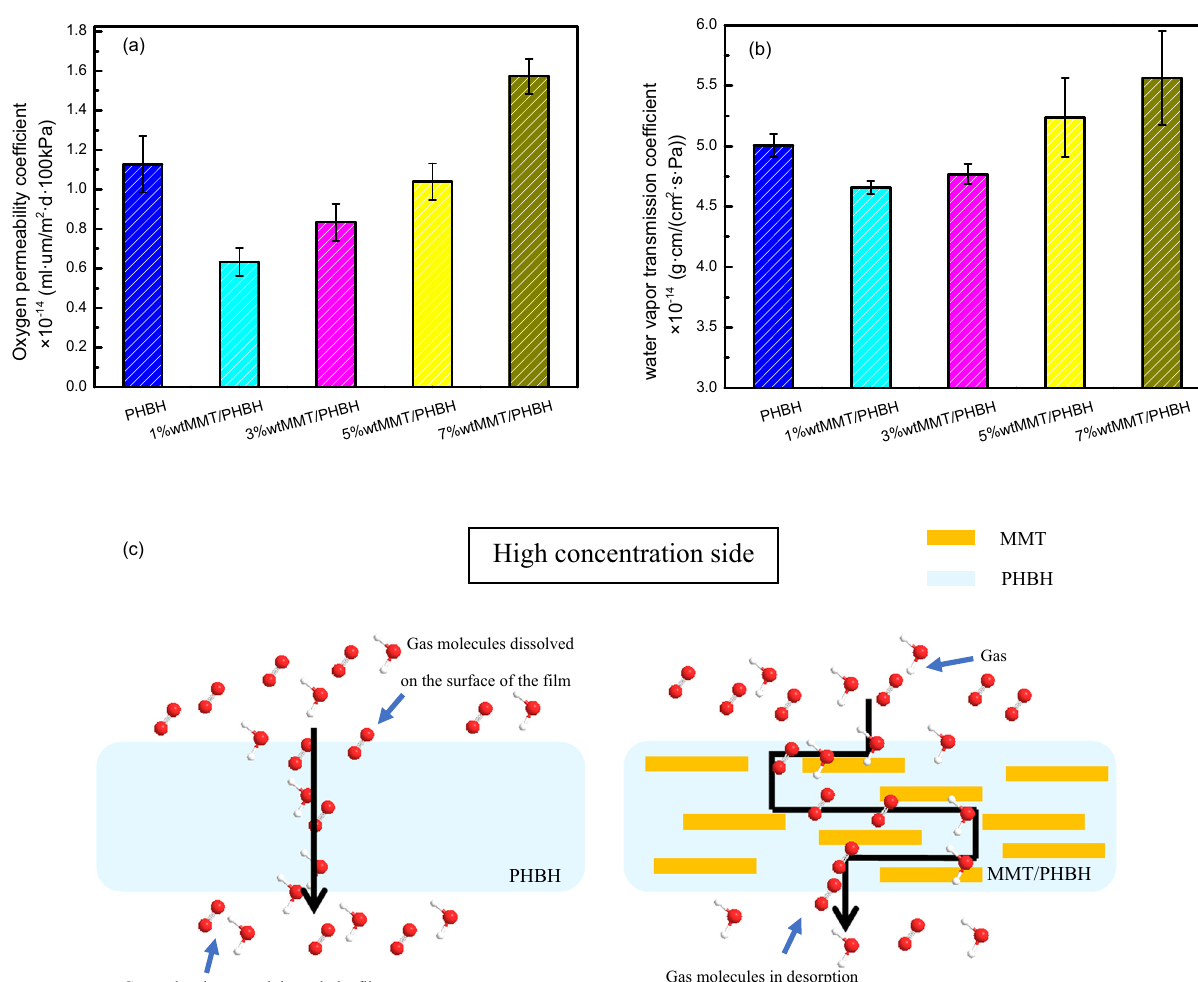
Figure 7: Blocking performance of MMT/PHBH ( a ) oxygen permeability coe ffi cient; ( b ) water vapor permeability coe ffi cient; ( c ) the tortuous zigzag di ff usion path in PHBH and MMT/PHBH nanobiocomposite when used as a gas